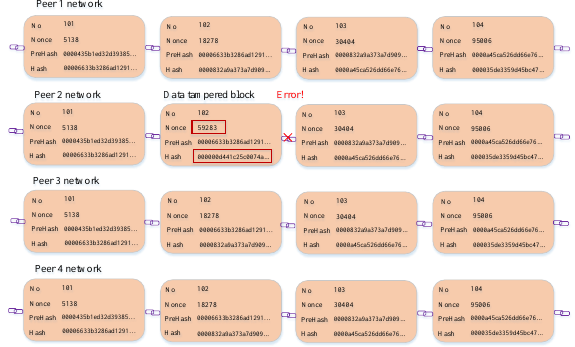
Figure 14. Data of the 102th